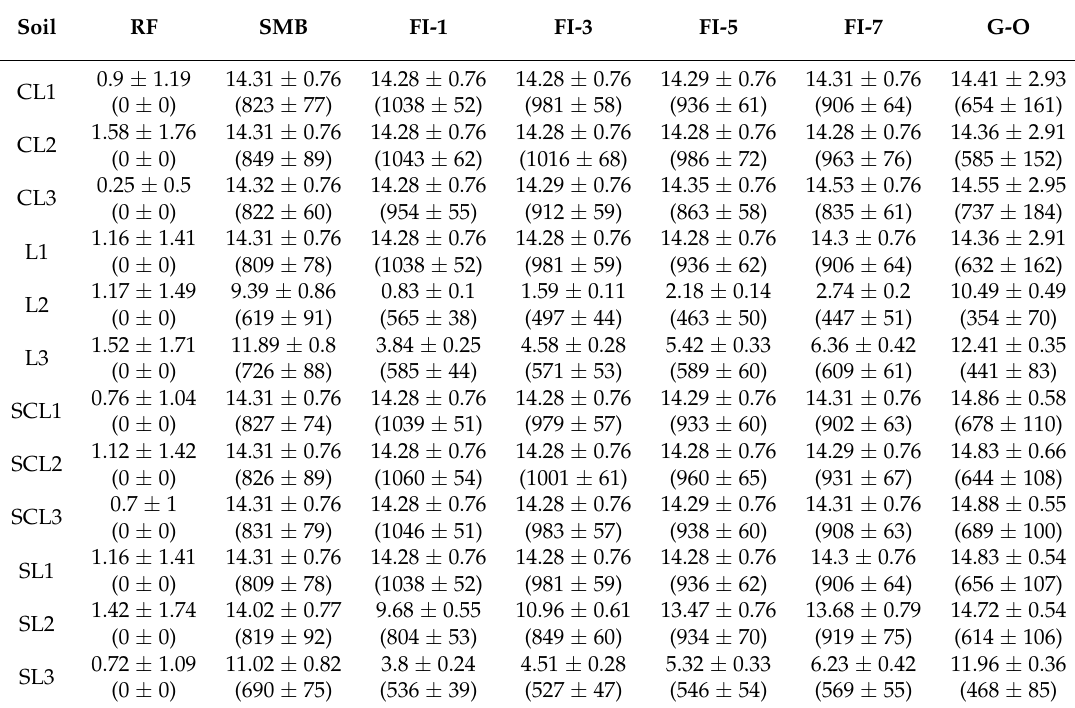
Table A2. Dry yield (in t ha − 1 ) and water use (in mm) for sugar beet, as a function of soil type according to irrigation strategy, as a mean value of simulated values from 1965 to 2016. Values outside and inside parentheses indicate dry yield and water use, respectively.